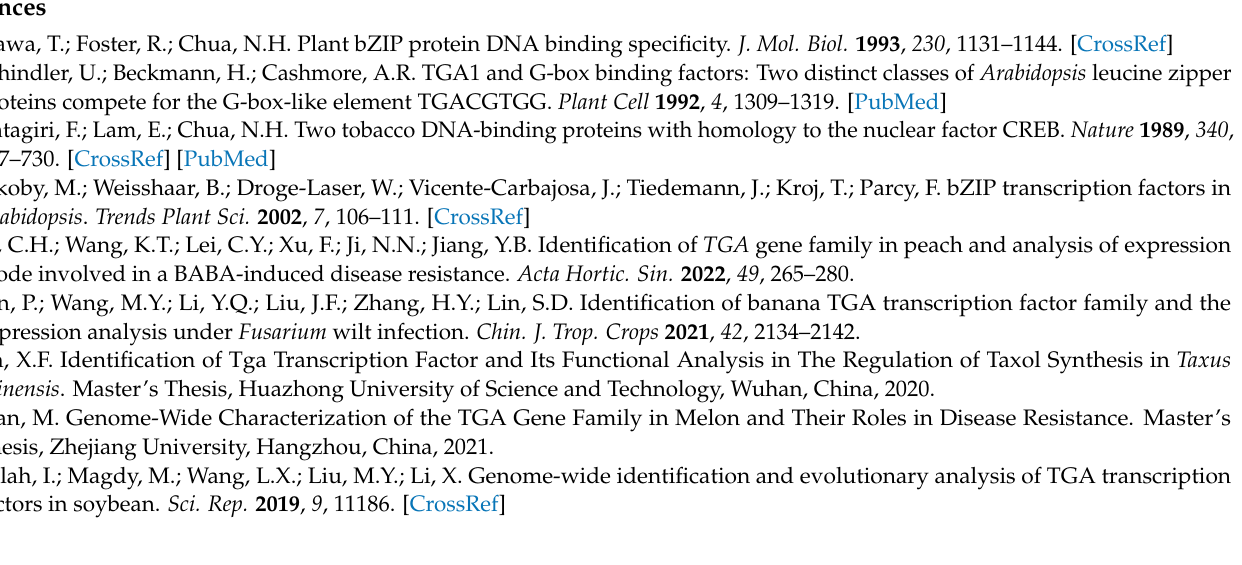
Table S3: The substitution rate ratio Ka/Ks and divergence time between the TGA gene family